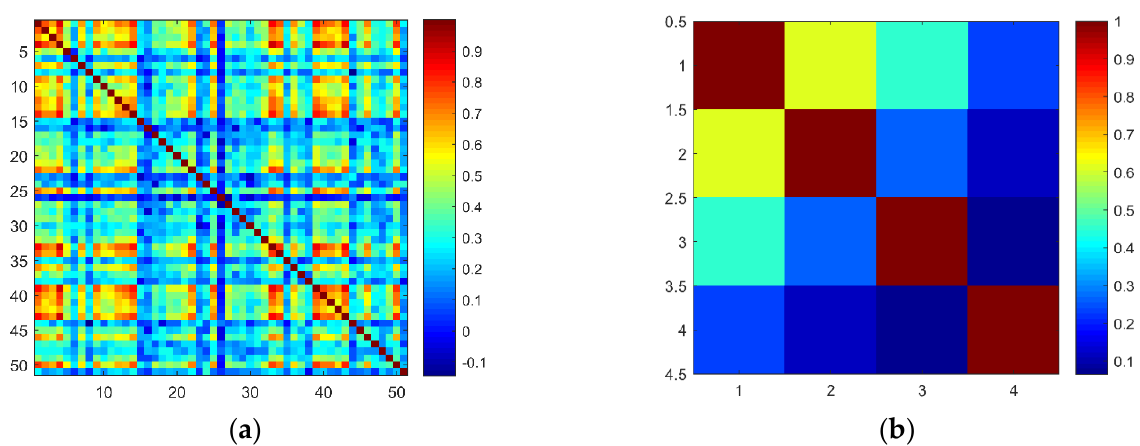
Figure 6. Correlation matrix for 50 simulated offshore wind assets ( a ) and four representative assets ( b ).